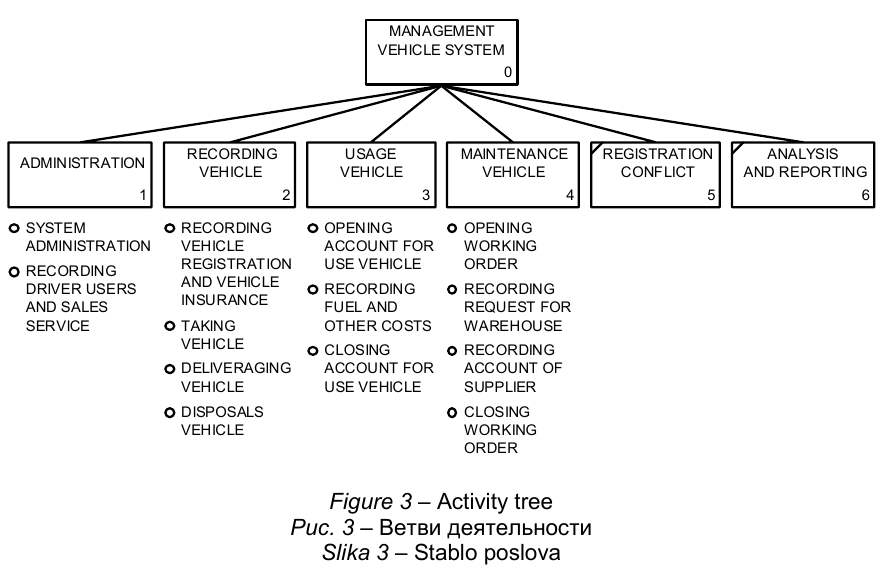
Figure 3 – Activity tree Рис . 3 – Ветви деятельности Slika 3 – Stablo